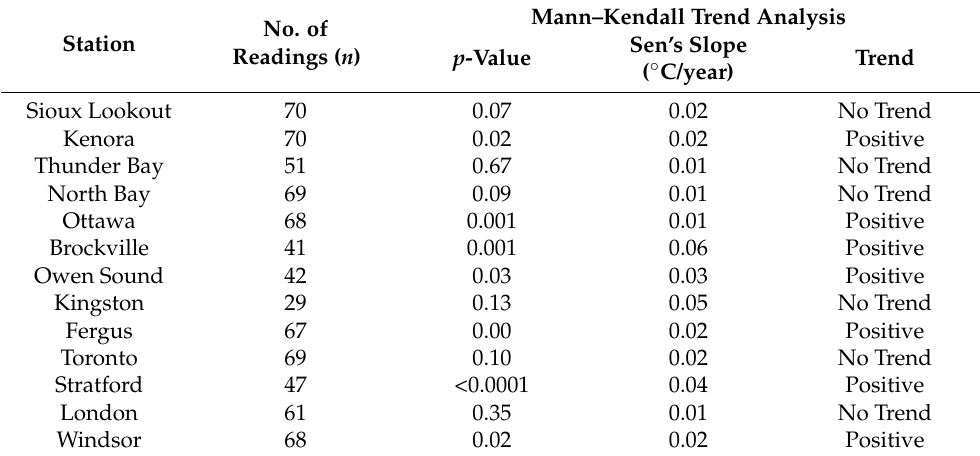
Table 2. Mann–Kendall tau and Sen’s slope analysis for Winter Mean Minimum Daily Temperature ( ◦ C). Mann–Kendall Trend No. of Station Readings ( n )